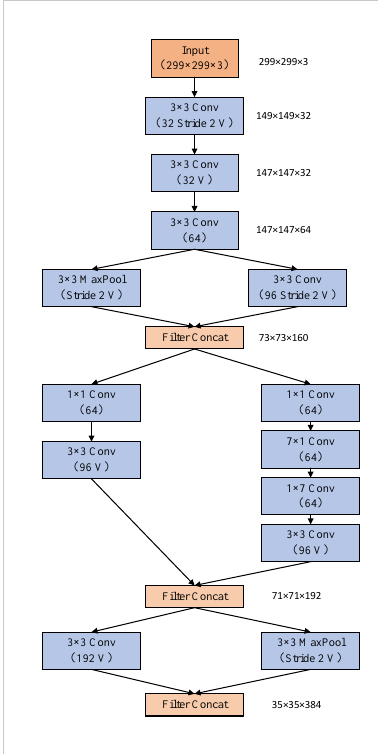
Figure 4. Structure of the stem